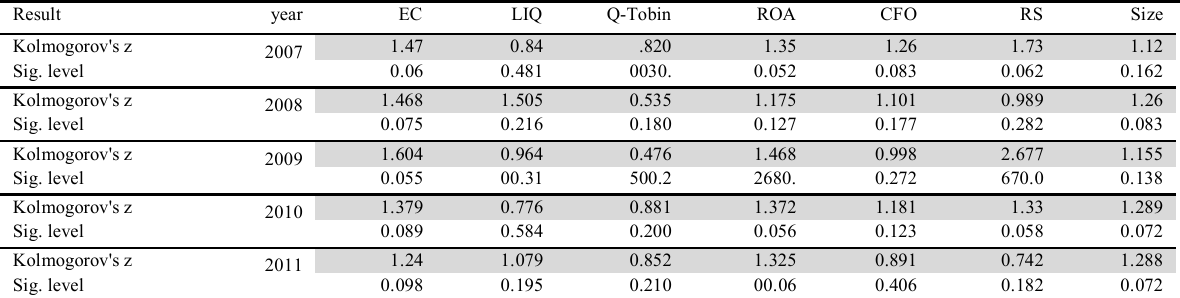
Normality variables Test after Normalization